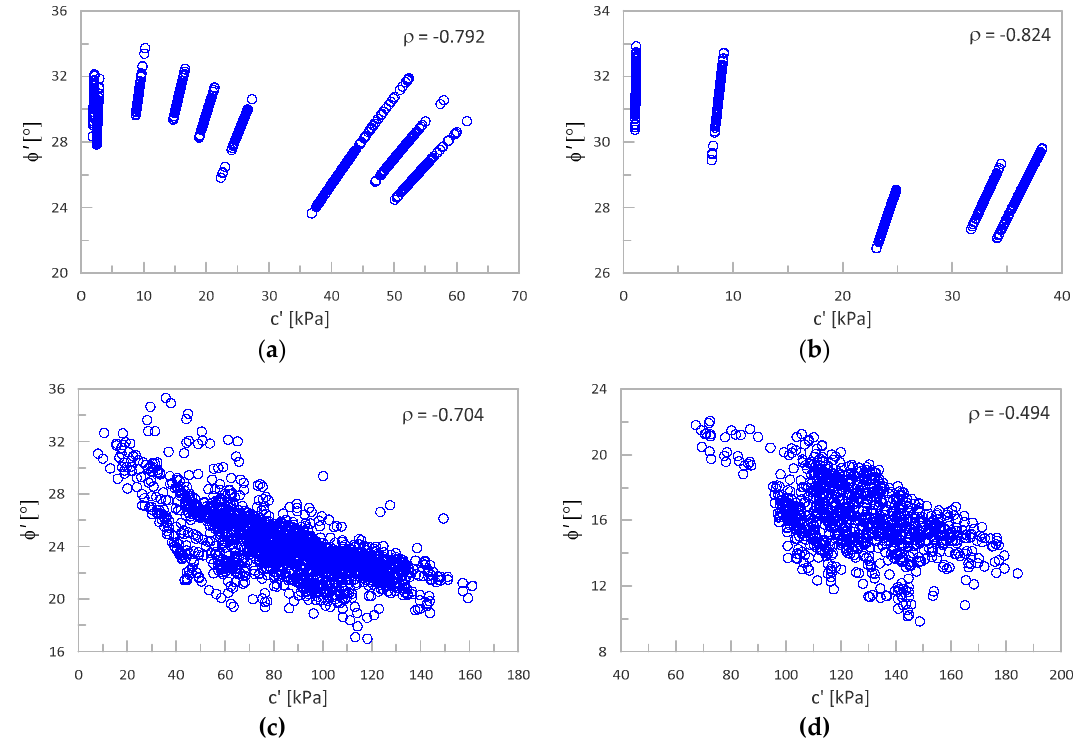
Figure 15. The value of the correlation coefficient ρ : ( a ) ´Swierzna clay ( b ) Keswick clay (the); ( c ) ´Swierzna clay ( d ) Keswick Figure 15 . The value of the correlation coefficient ρ : ( a ) Ś wierzna clay ( b ) Keswick clay (the); ( c ) Ś wierzna clay ( d ) Keswick clay (the clay (the MoE).